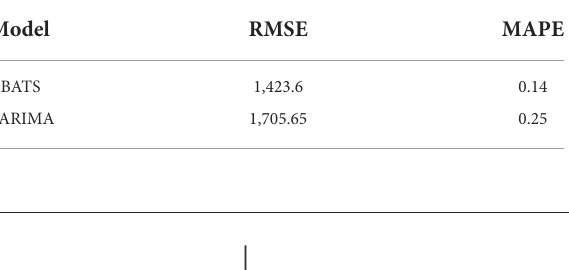
TABLE 2 Comparison of the model fitting effect.